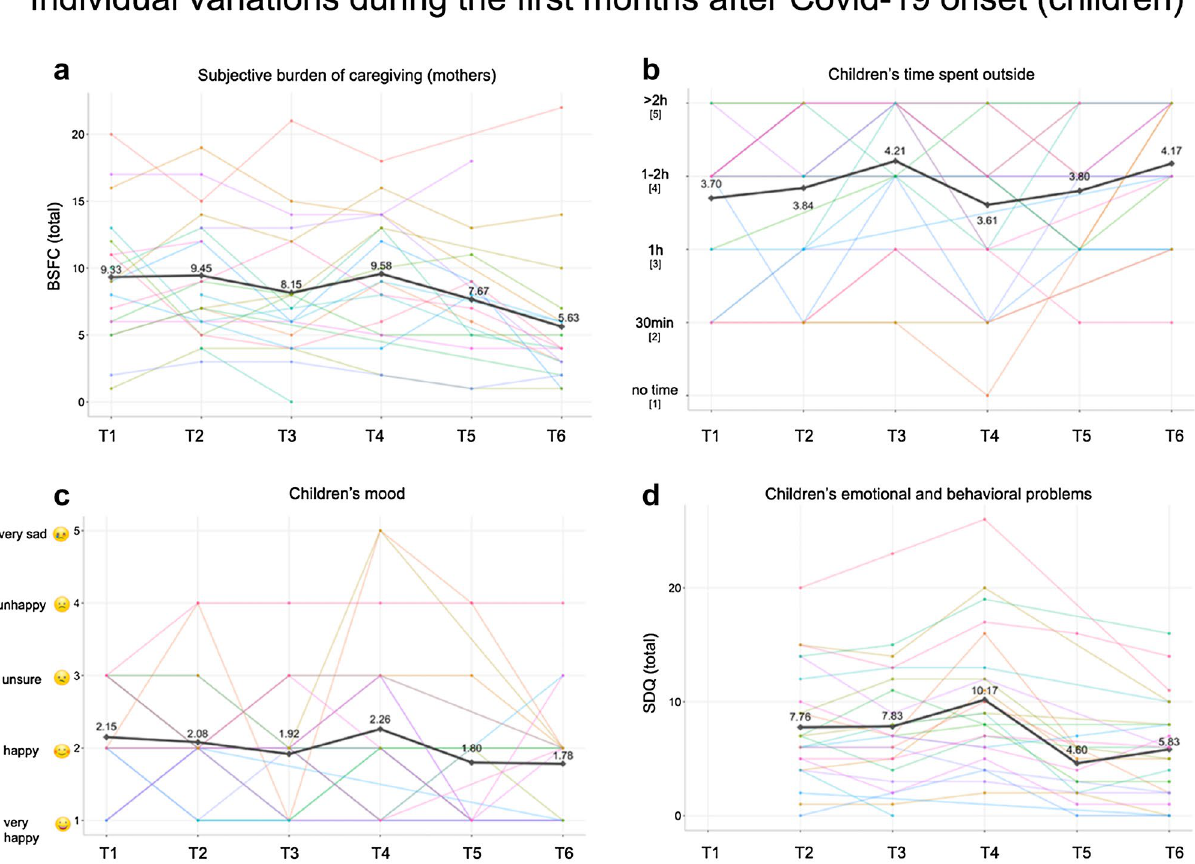
Figure 3. Variations of group mean (bold) and individual (colorful) scores in mental well-being across the first months of Covid-19 onset in children and mothers. ( a ) Variation in mothers’ subjective burden. ( b ) Variation in children’s time spent outside. ( c ) Variation in children’s mood. ( d ) Variation in children’s emotional and behavioral problems.